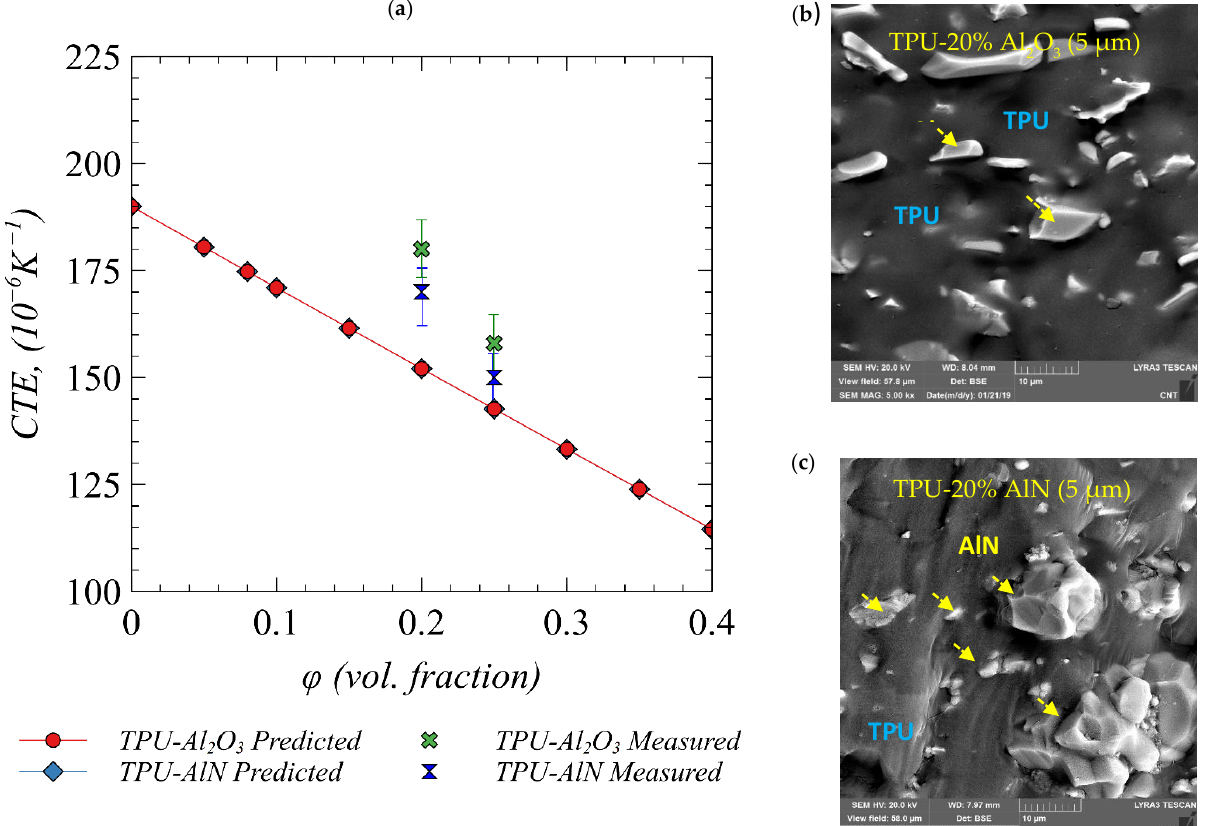
Figure 10. ( a ) The prediction of effective CTE of TPU/Al 2 O 3 and TPU/AlN composites as a function of filler loading. The measured CTE values of these composites systems with 20 vol% and 25 vol% loadings are also shown. ( b ) FESEM images of TPU/Al 2 O 3 20 vol% AlN (5 µm) loading. ( c ) FESEM images of TPU/AlN 20 vol% AlN (5 µm) loading.